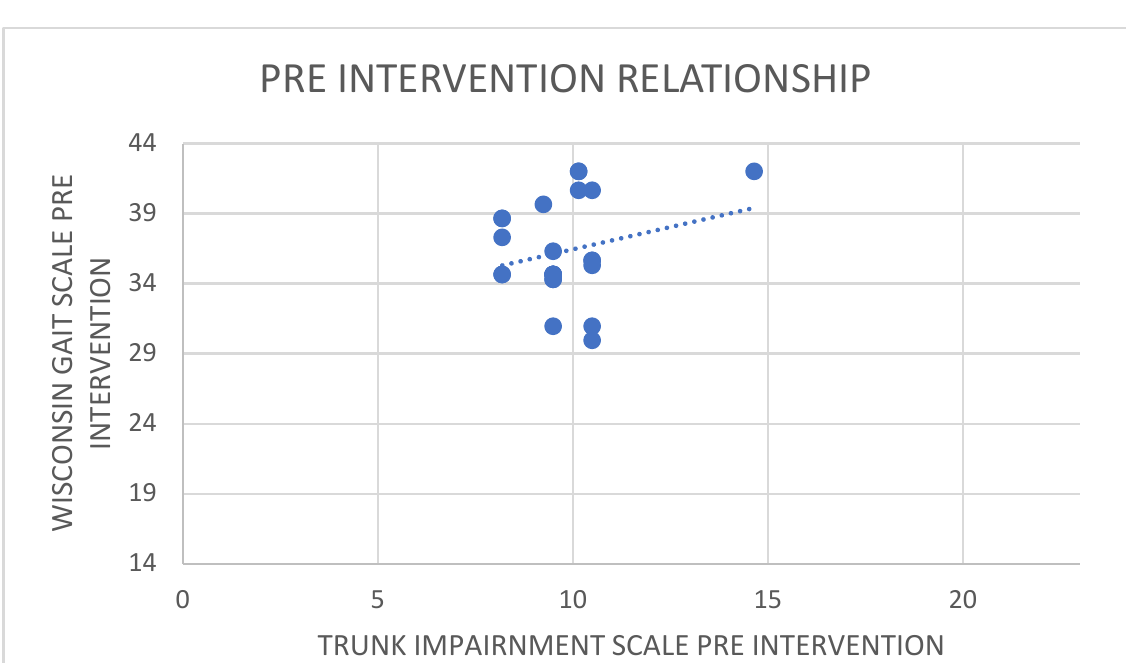
Figure 5. Scatter plot for pre and post data for both trunk impairment scale and Wisconsin gait scale-2 axis (Y-Y).